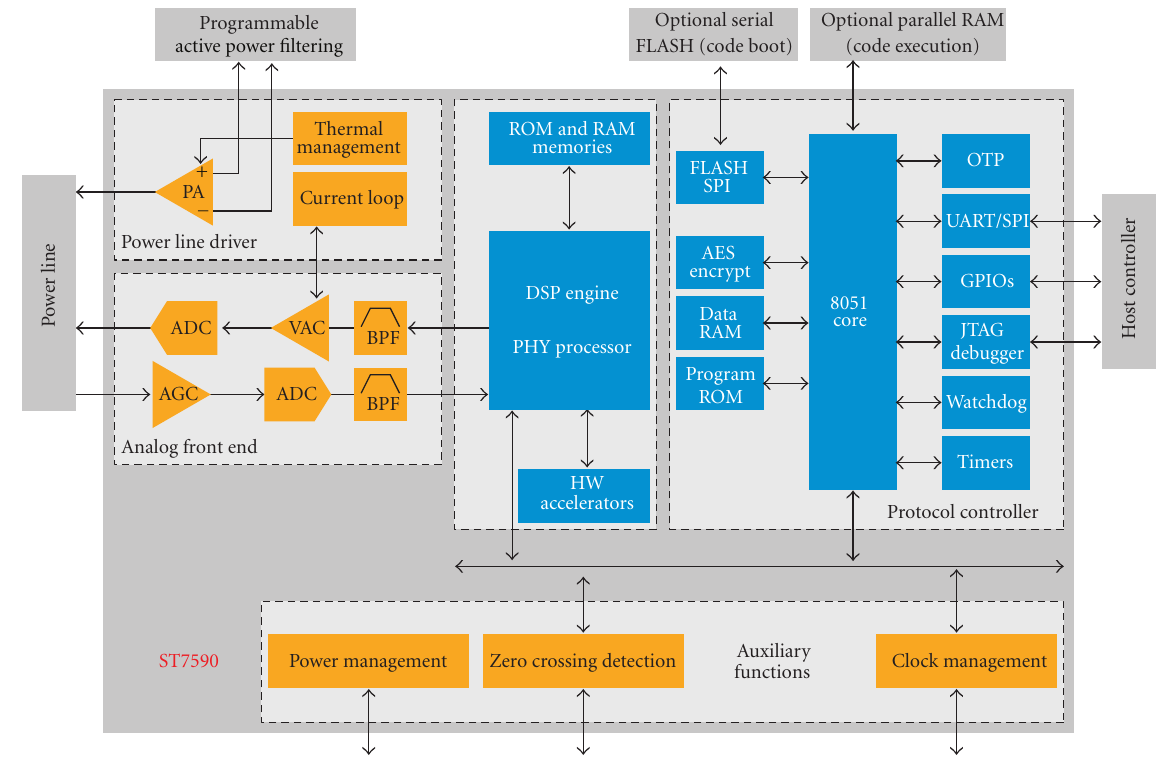
Figure 13: Architecture of the ST7590 PLC modem